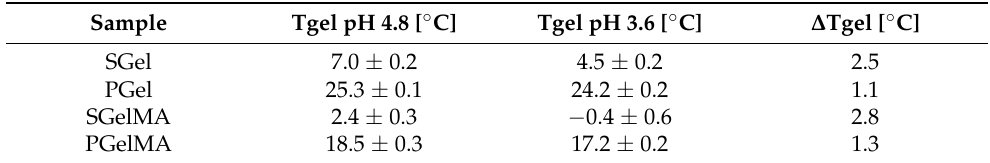
Table 3. Gelation temperature (Tgel) of different gelatin suspensions (10% w / v ) determined by rheology, and differences in Tgel due to differences in pH ( ∆ Tgel). Values are presented as average ± standard deviation.